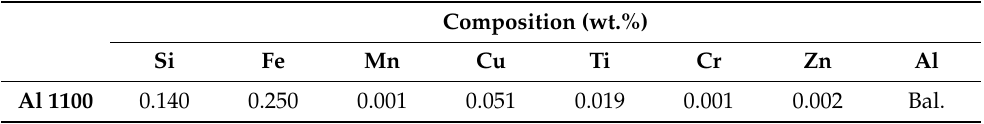
Table 1. Chemical composition of the 1100 aluminum plate used in the study. Composition (wt.%)